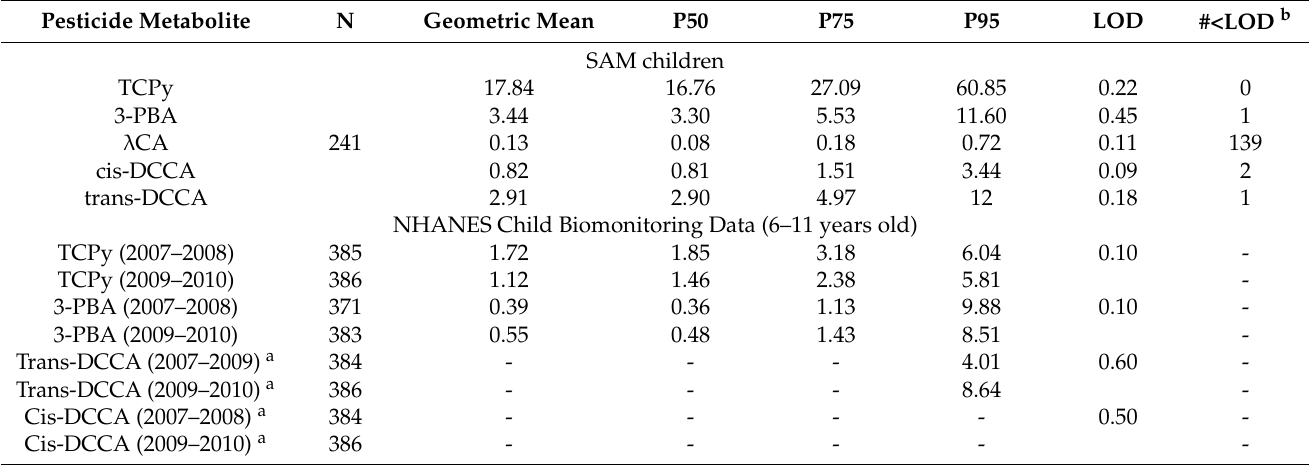
Table 2. A comparison of urinary pesticide metabolite concentrations (ng/mg creatinine) among children with complete data ( n = 241) aged ~7 years from Montevideo with children aged 6–11 years from the U.S. population.